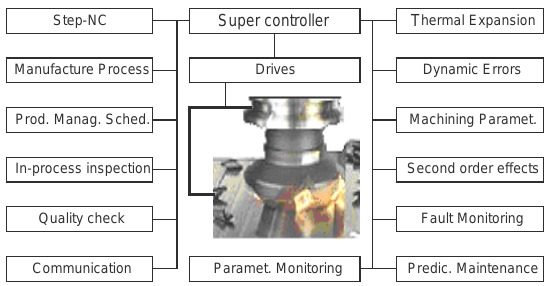
Figure 1. Error mapping in machine